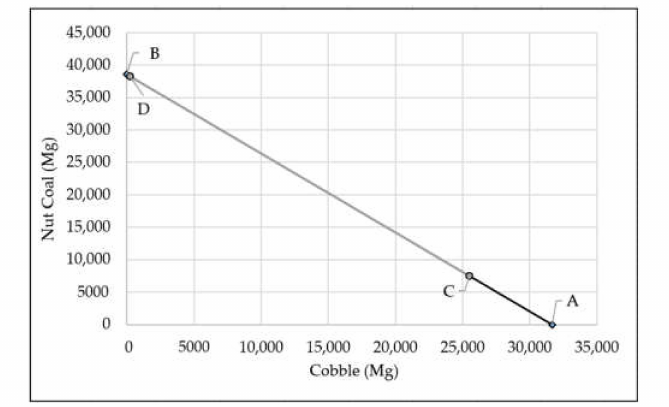
Figure 1. Graphic presentation of the BE on the analysed case.